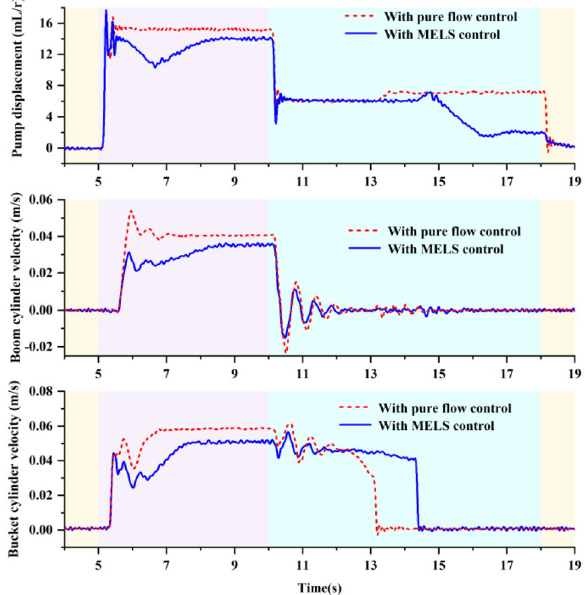
Figure 15 Pump displacement and cylinders velocity